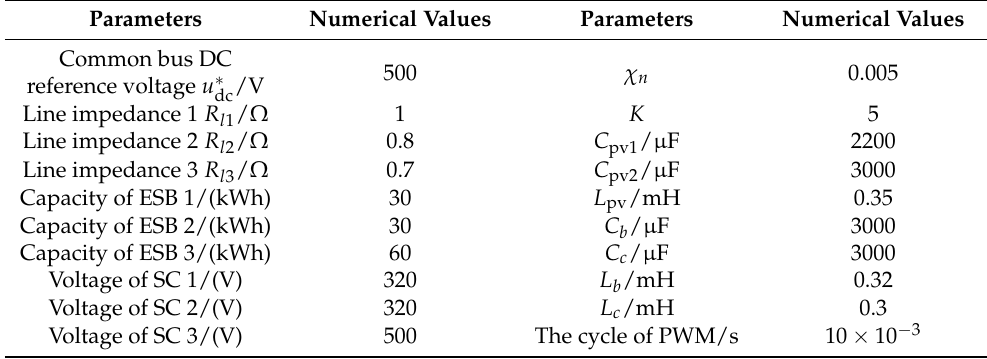
Table 2. Simulation model parameters